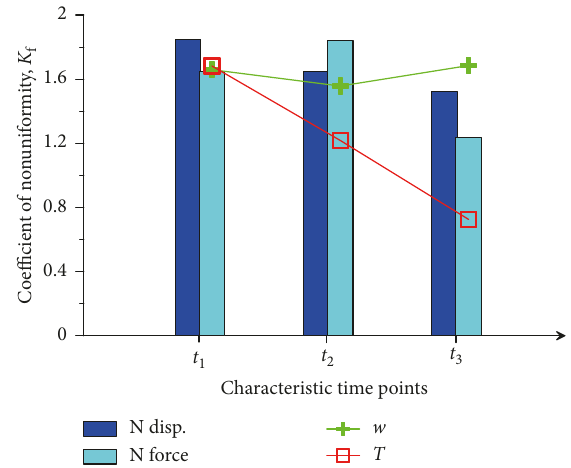
Figure 10: Nonuniform frost heave index at three durations.